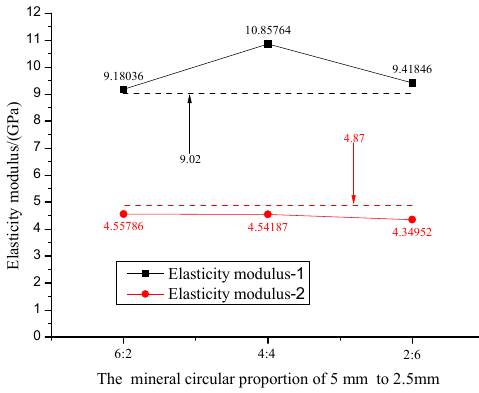
Figure 27. Mean value of elastic modulus for proportions of different size minerals.